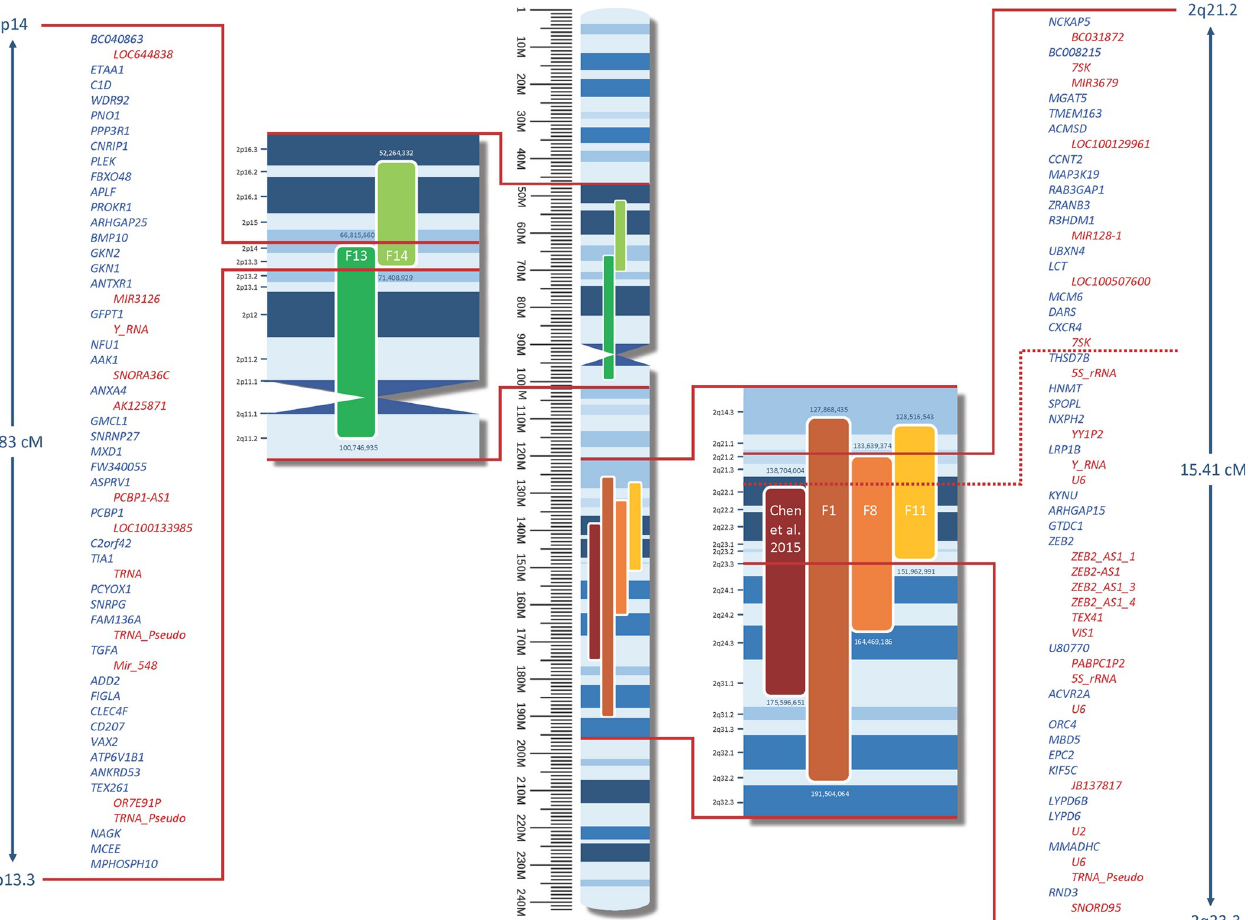
Fig 3. Candidate loci on chromosome 2. Coloured bars = loci supported by individual families; figures above and below these loci = physical (bp) position; bp = base pairs; M = mega base pairs; cM = centimorgan; red lines = enlarged overlap area; blue = protein-encoding genes; red = non-protein-encoding elements. All genes and positions in relation to GRCh37.p13